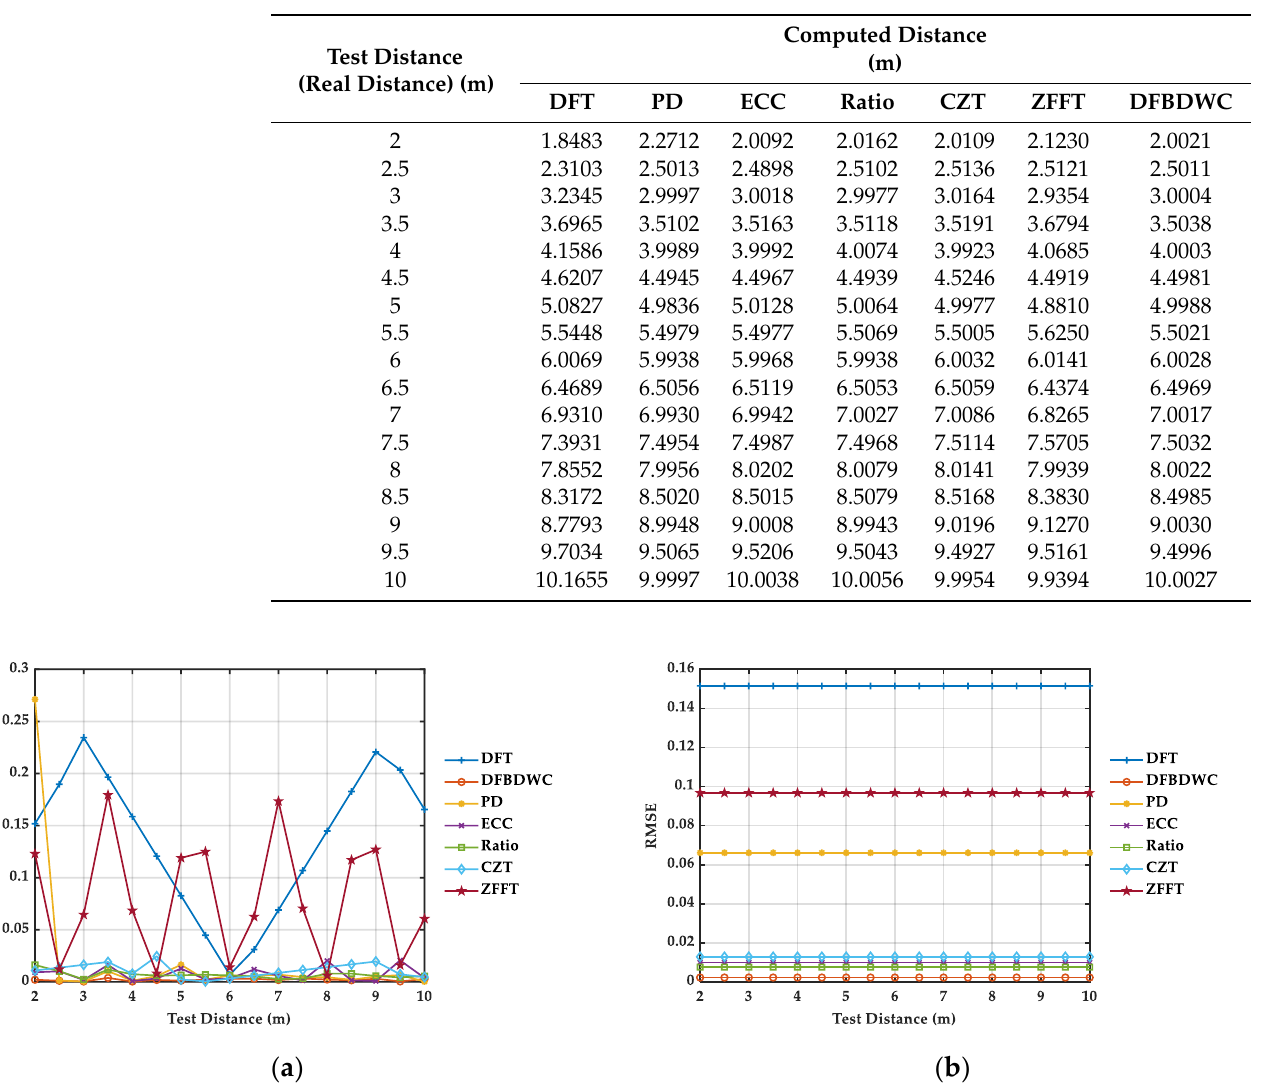
Table 3. Simulation results of computed distances comparison between seven algorithms. There are WGN signals with SNR of 10 dB in s B ( n ) .